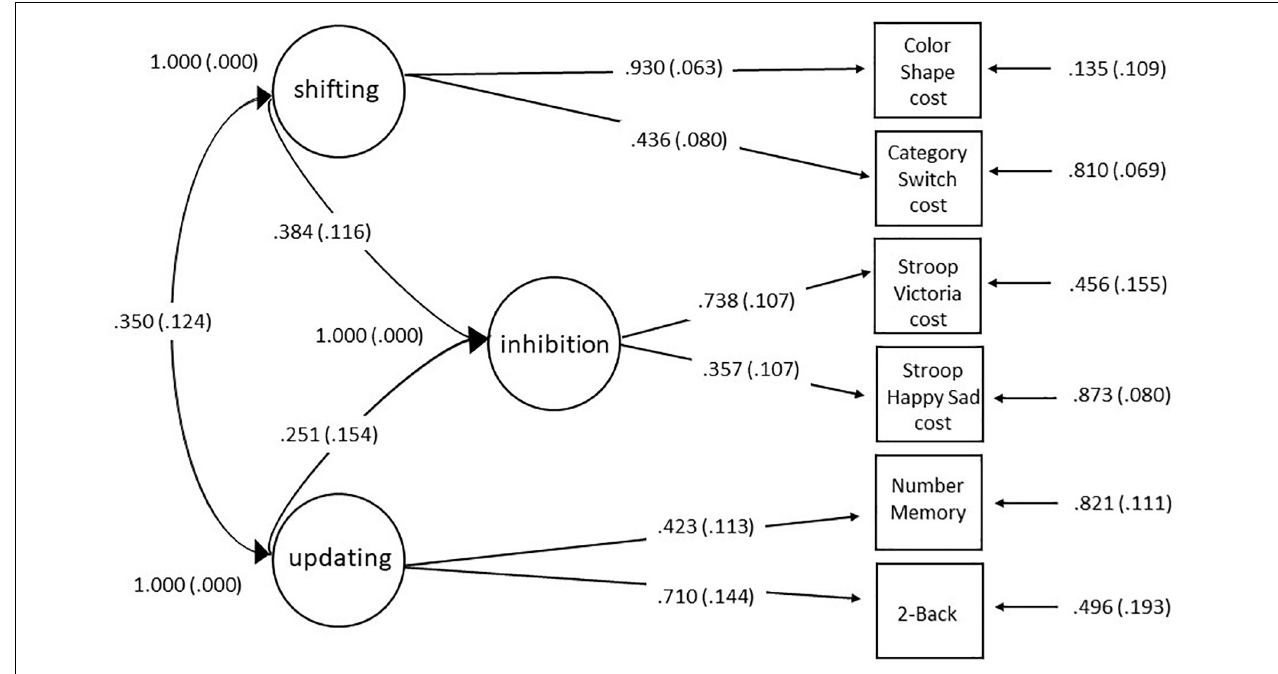
FIGURE 4 | Three correlated factor solution obtain with confirmatory factor analysis of the unity and diversity executive functions model, including factor loadings of each executive measure (represented as squares) on each executive latent variable domain (represented as the ovals). See text for model fits. In the shifting and inhibition measures, scores were reversed ± signed so that higher scores always indicate better